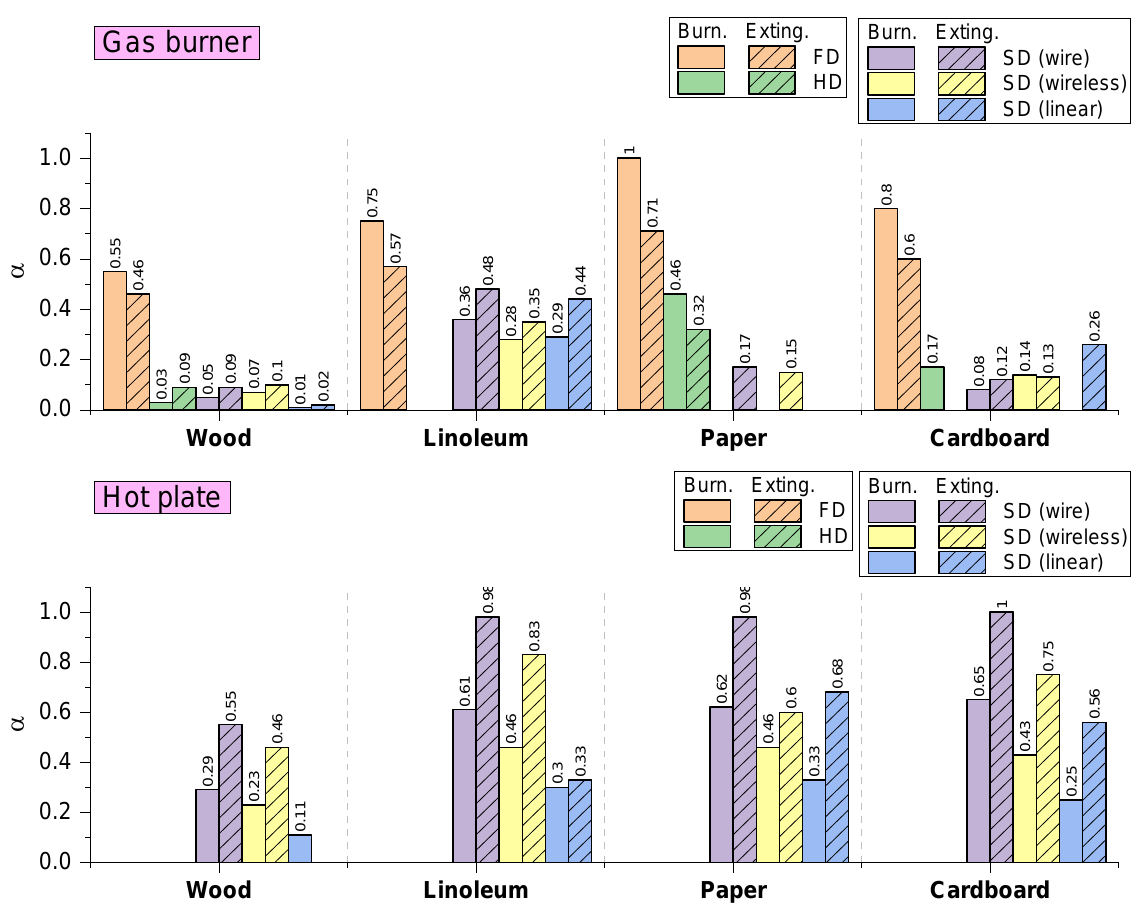
Figure 12. Fire detector efficiency factor when reproducing the conditions of careless handling of fire and improper use of heating equipment for all the model fires under study without extinguishing and with water application. Table 3. SD activation delay times when varying the hot plate surface temperature under imitated conditions of unsafe operation of heating equipment without fire